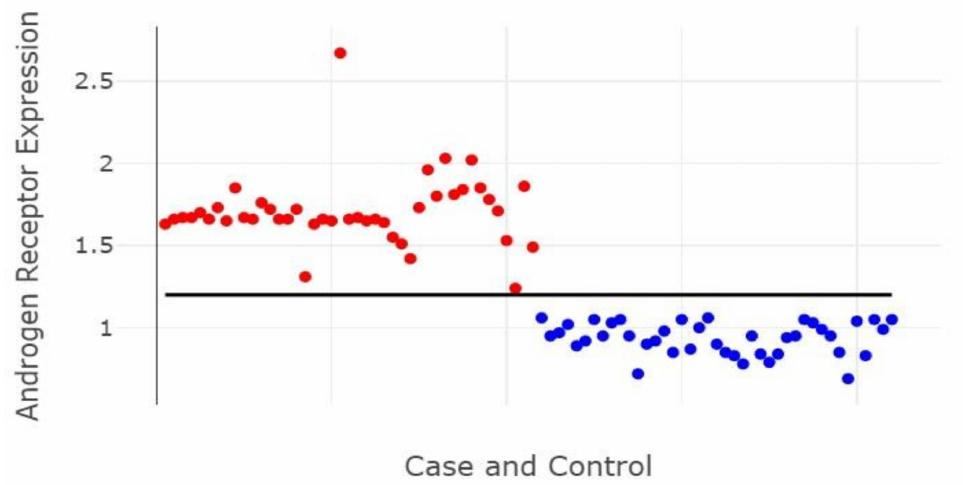
Figure 5. Correlation of the relative expression of the androgen receptor (AR) with NPH (blue) and CaP (red) patients. The Y -axis represents the expression of androgen receptor by the Western blotting method, and the X -axis represents each individual in the sample. Blue dots—control group; red dots—group case; black line—value of 1.2 expression of androgen receptor in the Western blot method.